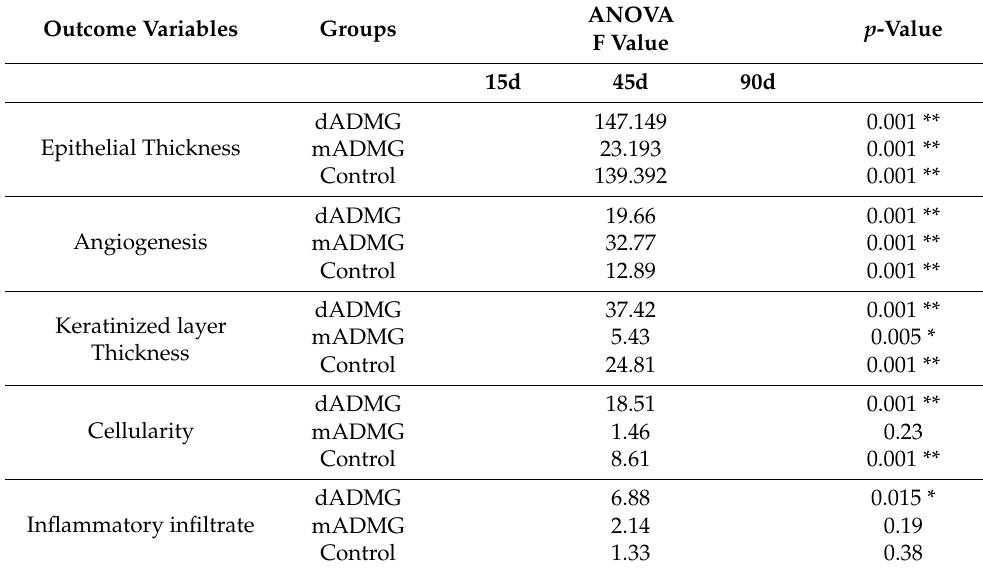
Table 2. one-way ANOVA for the comparison of changes in outcome parameters during the follow-up time intervals between ADMG grafts and control groups.